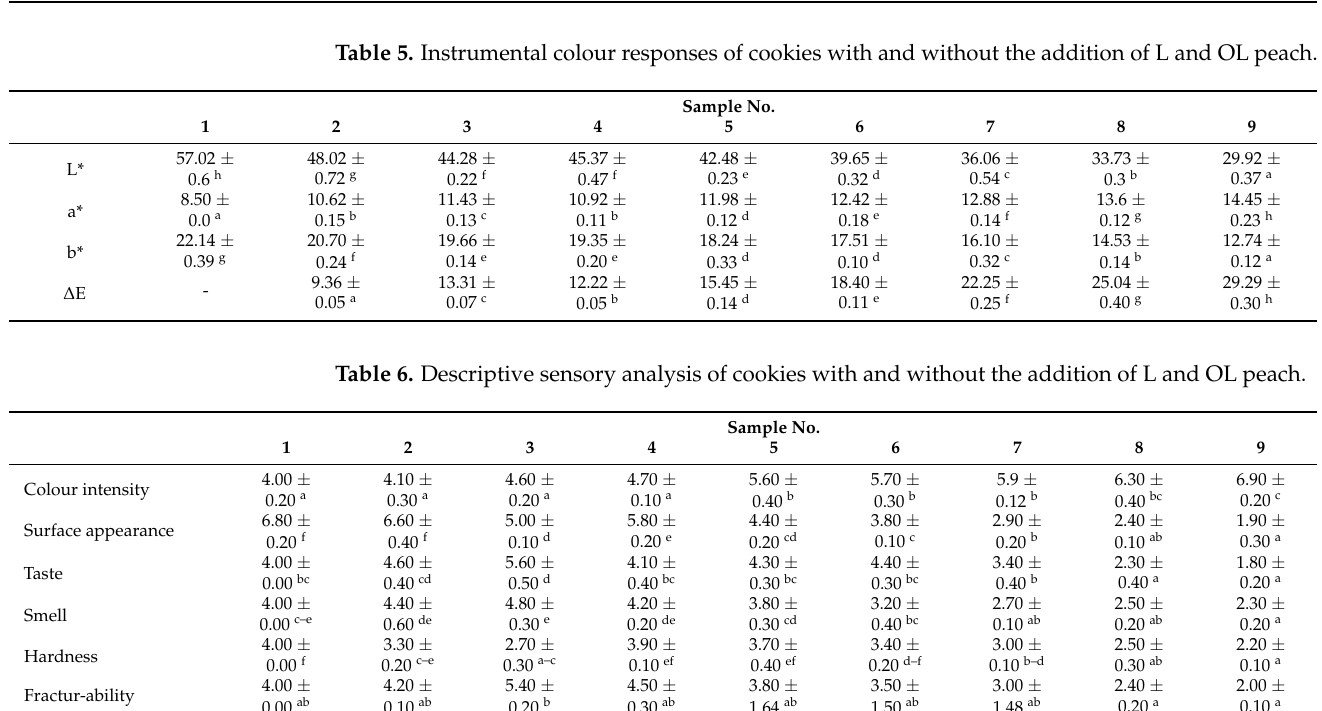
Table 5. Instrumental colour responses of cookies with and without the addition of L and OL peach.